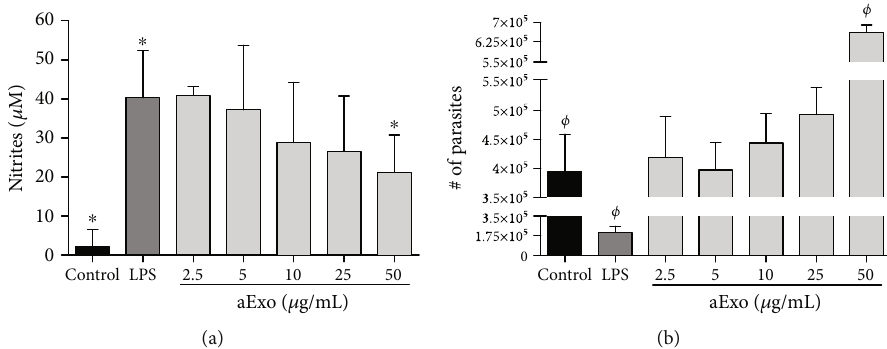
Figure 4: aExo from L. mexicana reduce NO production and favor parasite survival within iBMMs. For NO production analysis, iBMMs were coincubated with LPS (100ng/mL) and aExo in suspension (2.5, 5, 10, 25, and 50 μ g/mL) for 24 h, and cell supernatants were collected, and nitrates were quanti fi ed. For intracellular survival assay, iBMMs were stimulated with aExo for 24 h, washed, and further cultured for 72 h in RPMI medium supplemented with 10% FBS/-exo at 26 ° C. Di ff erentiated promastigotes were counted. (a) Nitrites production by iBMMs stimulated with aExo. (b) Survival of intracellular parasites released by BMMs after aExo stimulation. Data are presented as mean ± SD ( n = 3 ). Statistically signi fi cant di ff erences were determined using Mann – Whitney U test; p < 0 : 05 was considered signi fi cant, compared to control group.